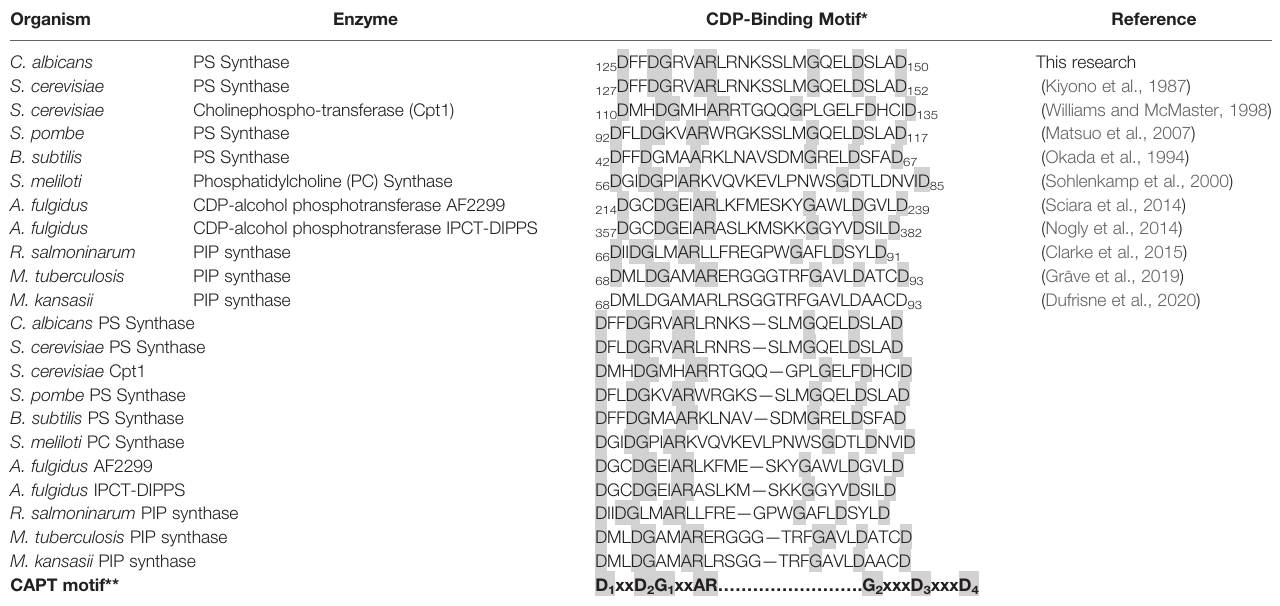
*Gray highlighted residues represent the conserved amino acids. **Bold amino acids represent conserved residues in the CAPT